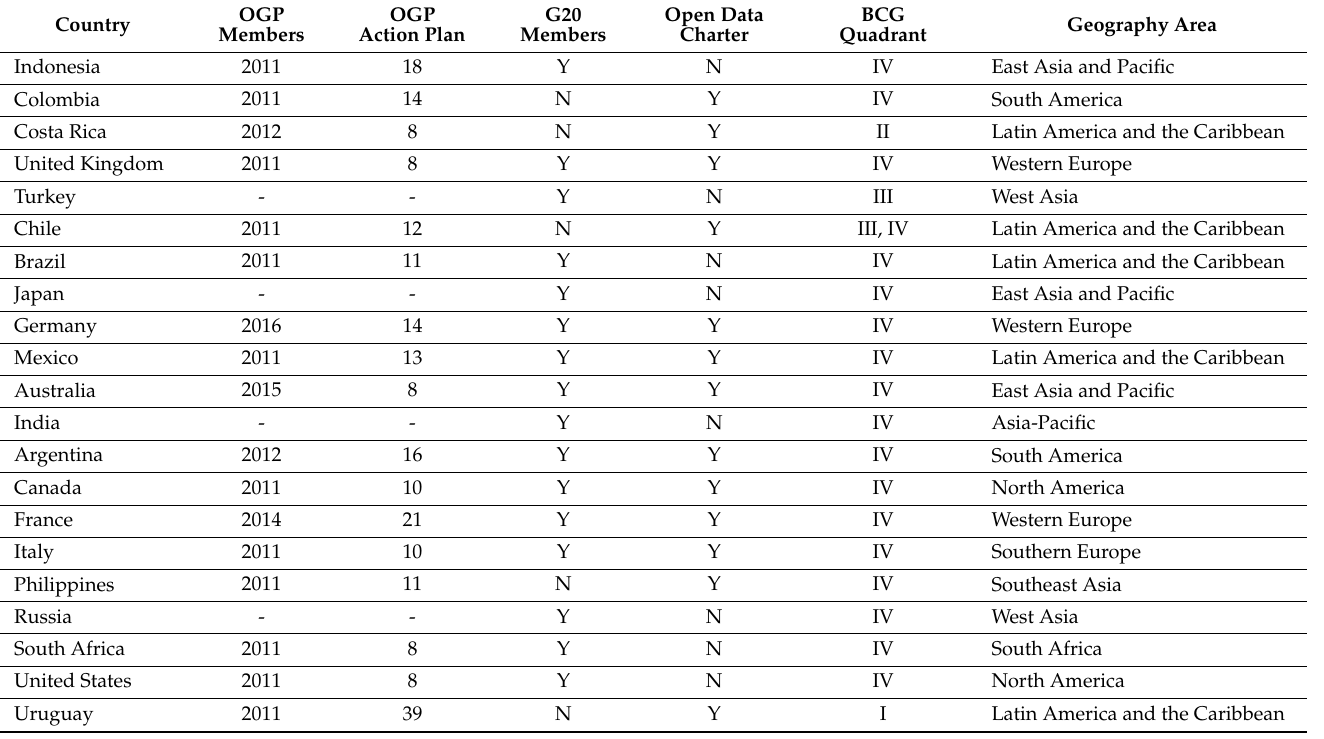
Table 10. Geography area of 21 countries and their